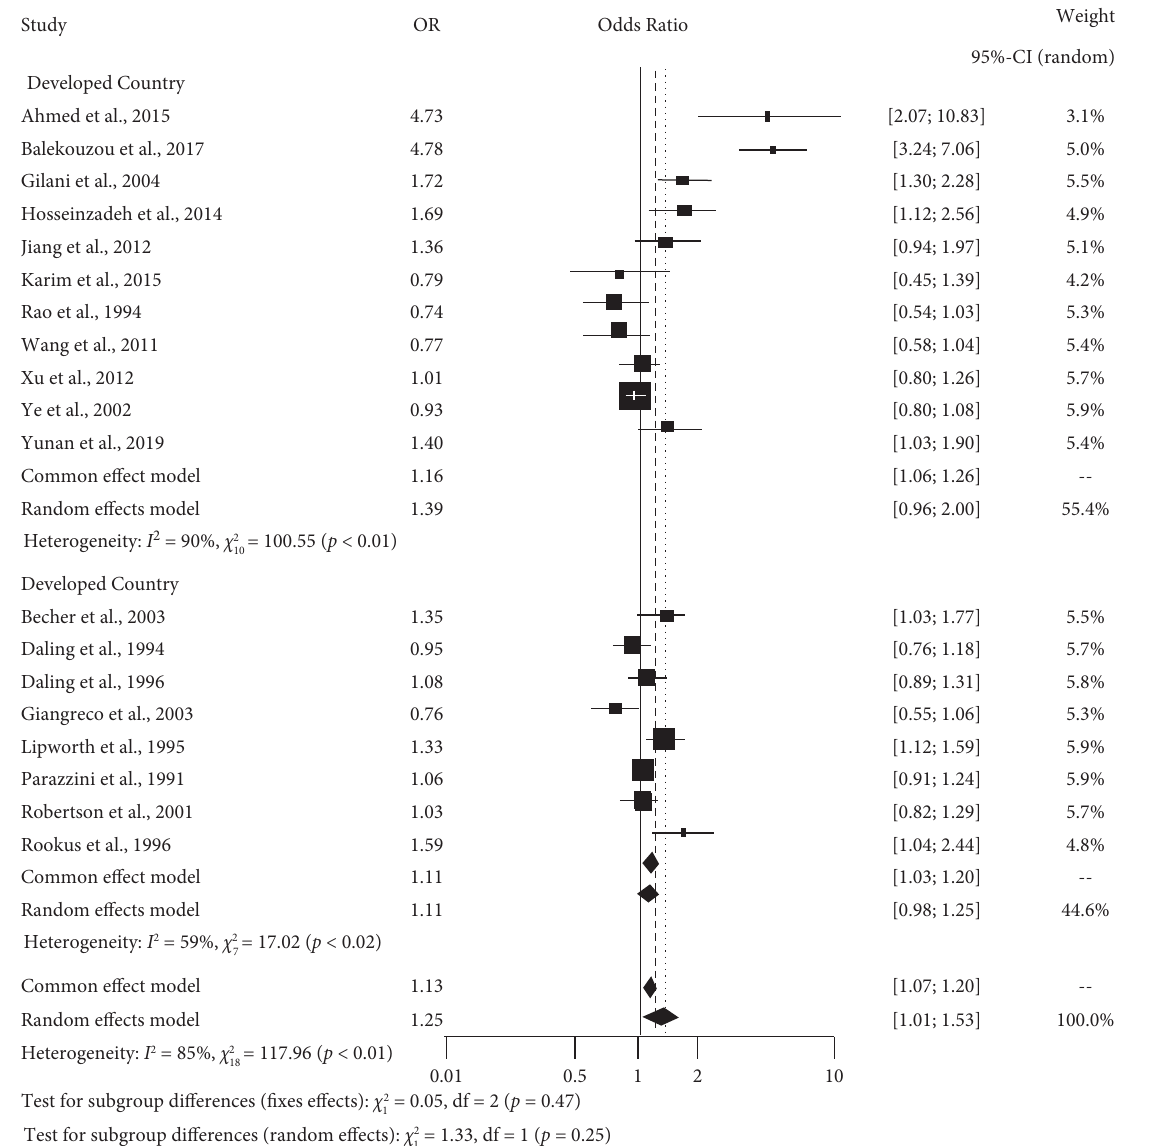
Figure 4: Forest plot showing subgroup analysis expressing the infuence of induced abortion case by country status (developing or developed) on breast